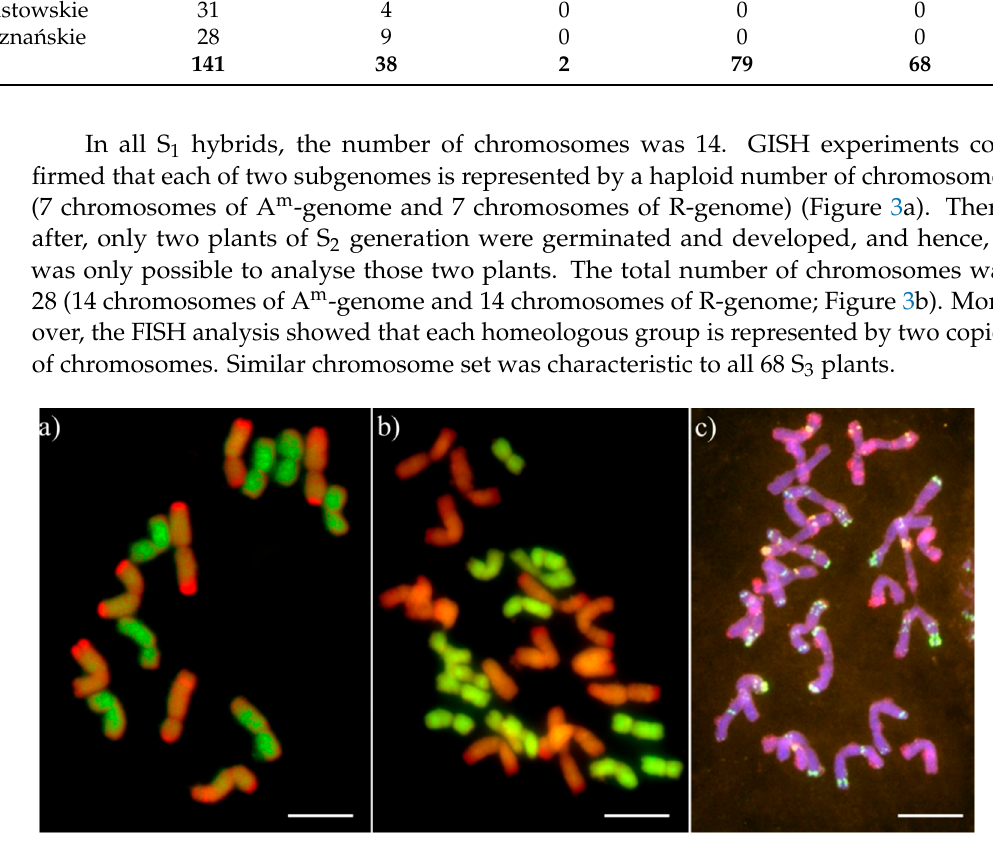
Table 4. Chromosome configurations during meiosis of Pollen Mother Cells (PMCs) at metaphase I analysed for S 2 and S 3 generation plants.